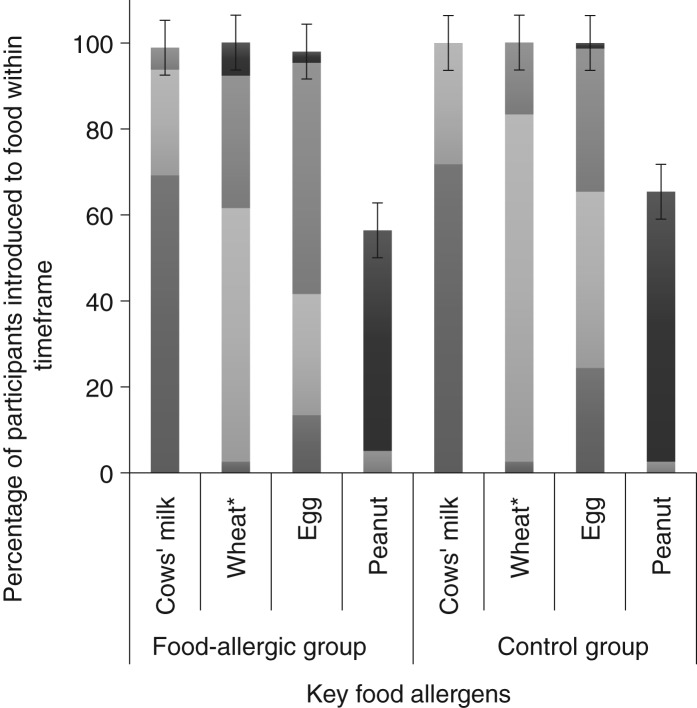
Timing of introduction of key food allergens to food-allergic (n 39) and control groups (n 78). * Significantly different between groups using Fisher's exact test (P = 0·011). , 9–12 months; , 6–9 months; , 3–6 months; , < 3 months. The error bars indicate 95 % confidence intervals.